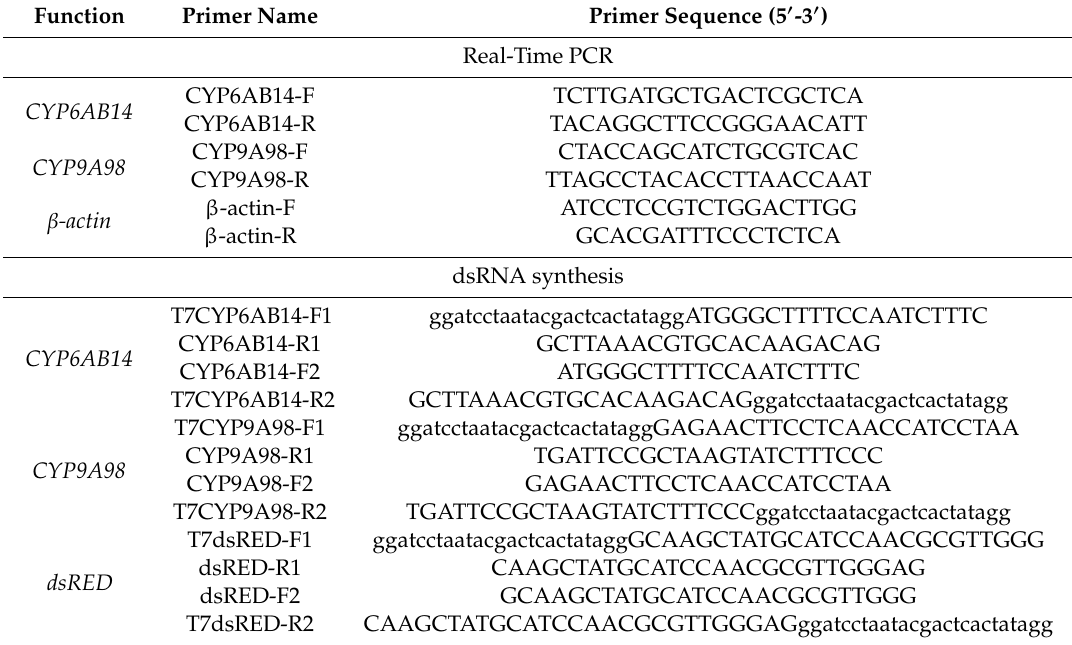
Table 2. Primers used in this